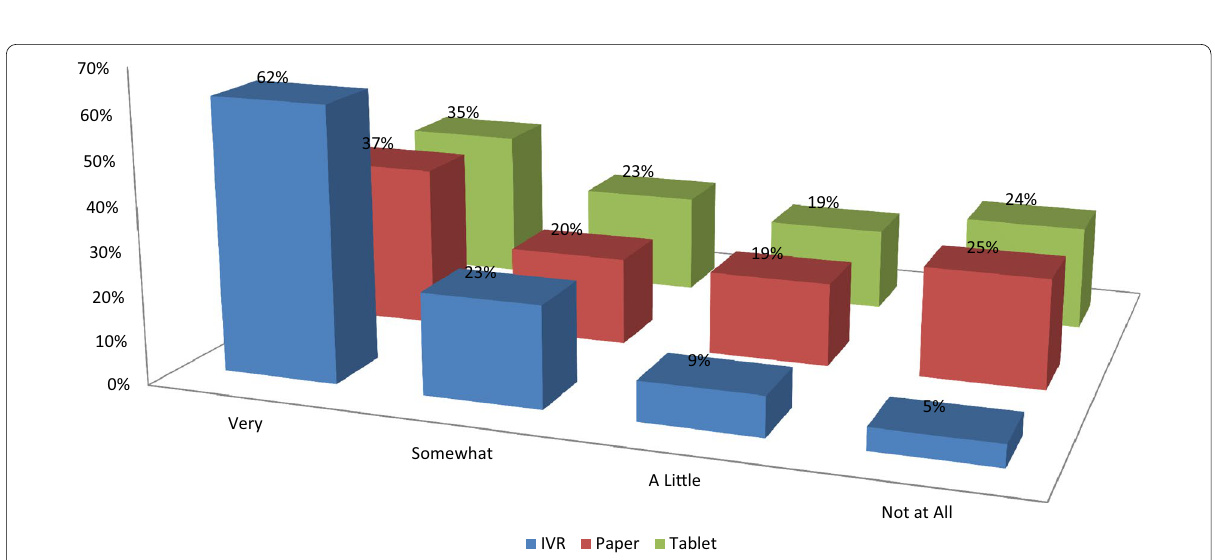
Fig. 6 How willing to use automated telephone